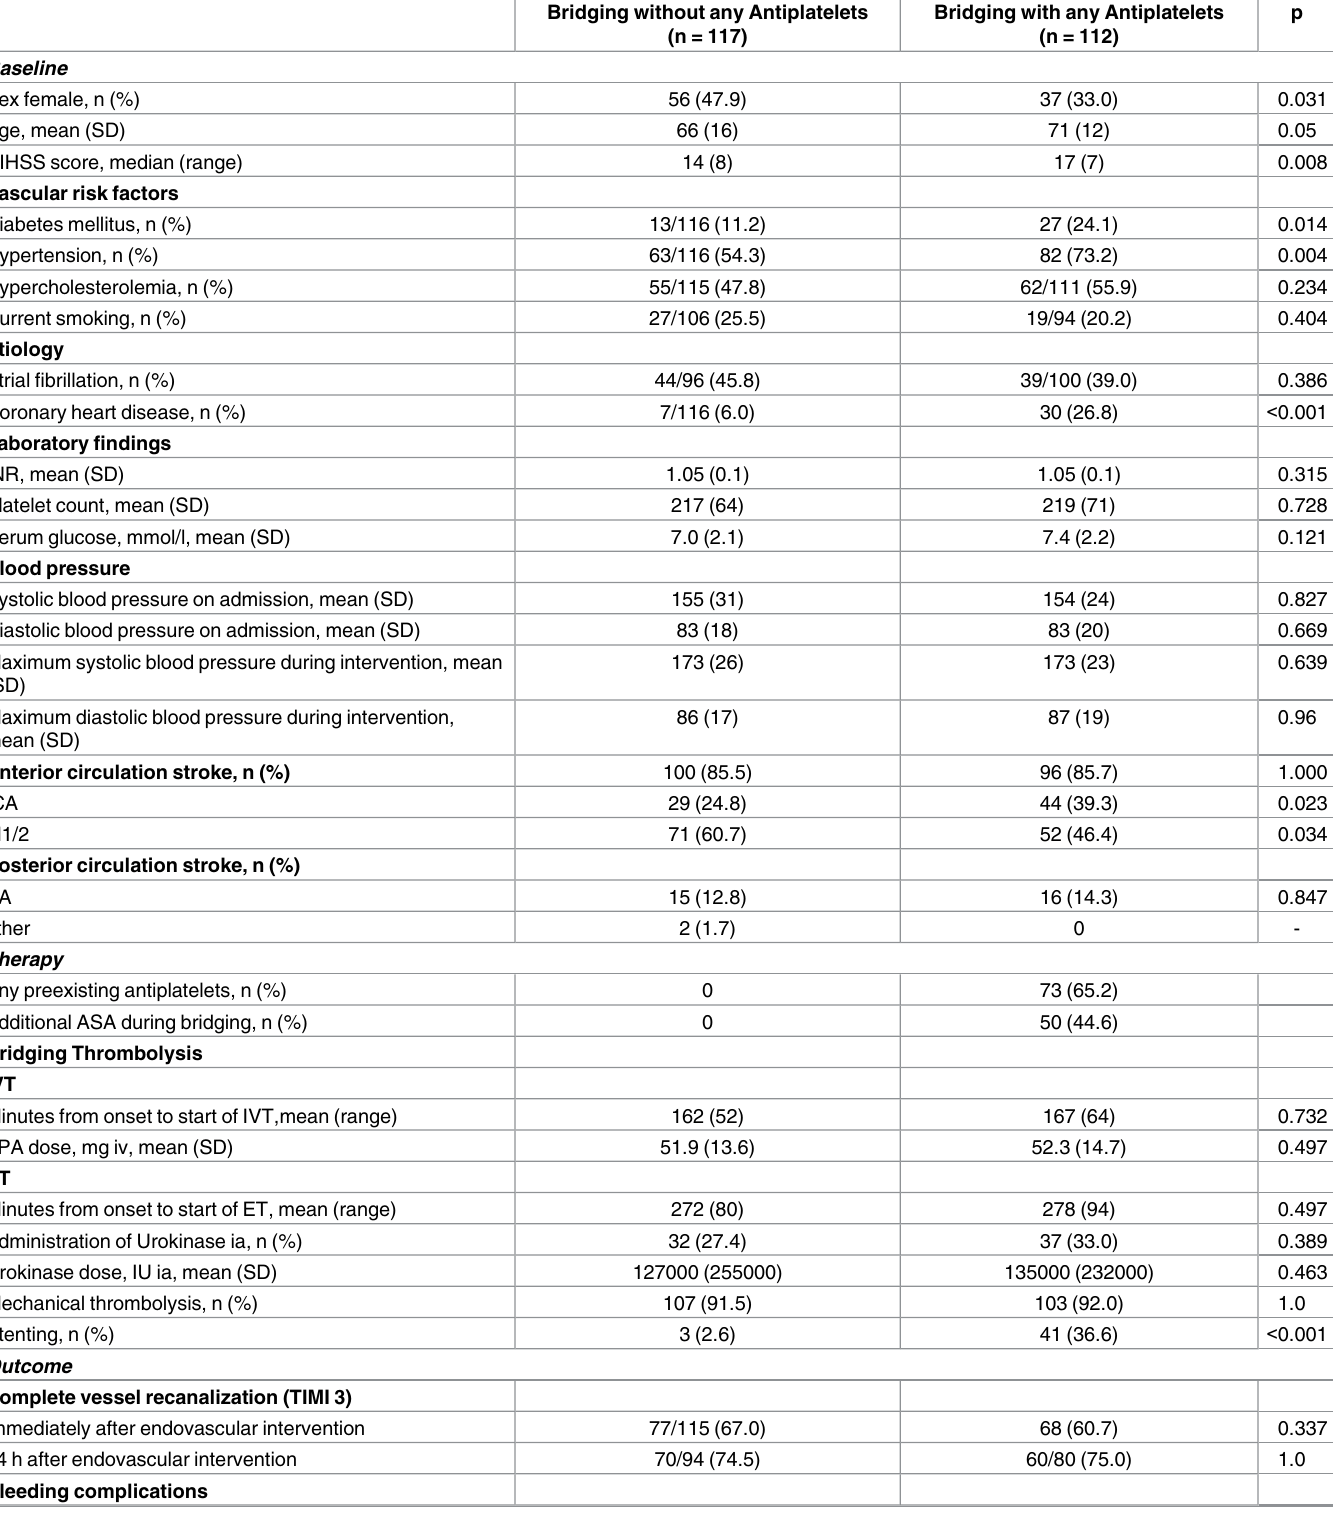
Table 4. Comparison between antiplatelet na ï vepatients and patients with prior and/or acute antiplatelet therapy †